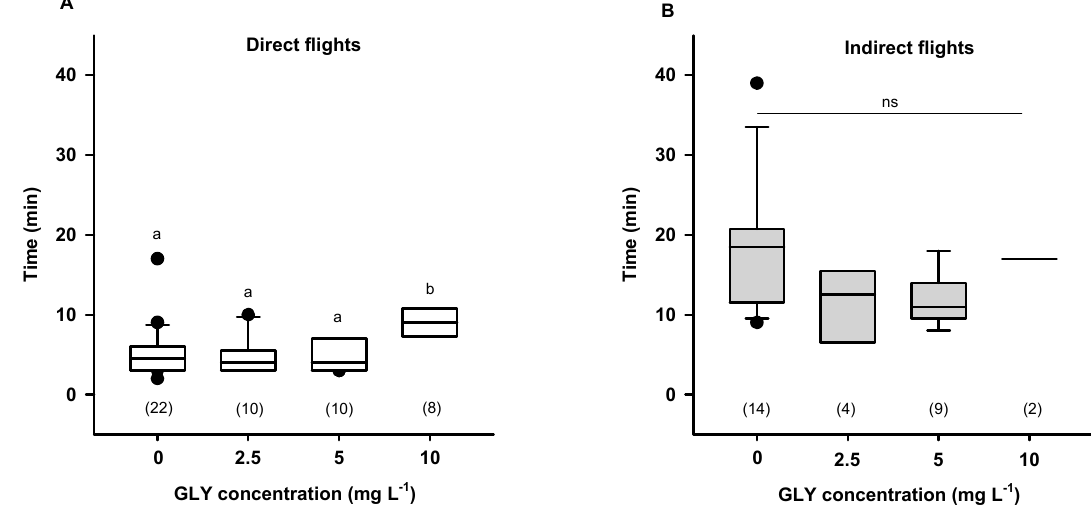
Figure 3. Effect of an acute exposure to GLY on forager homeward flight time after first release. Flying time (min) of bees from the release site to the hive after feeding sucrose solution with and without GLY (0 mg L − 1 : control, 2.5 mg L − 1 , 5 mg L − 1 , 10 mg L − 1 ). ( A ) Direct flights. ( B ) Indirect flights. Different letters represent statistically significant differences ( p < 0.05, Kruskal–Wallis test). ns: no significant differences ( p > 0.05, Kruskal–Wallis test). Numbers in brackets indicate the number of bees tested for each treatment. Reproduced with permission from Balbuena and co-workers, Journal of Experimental Biology; published by The Company of Biologists, 2015.